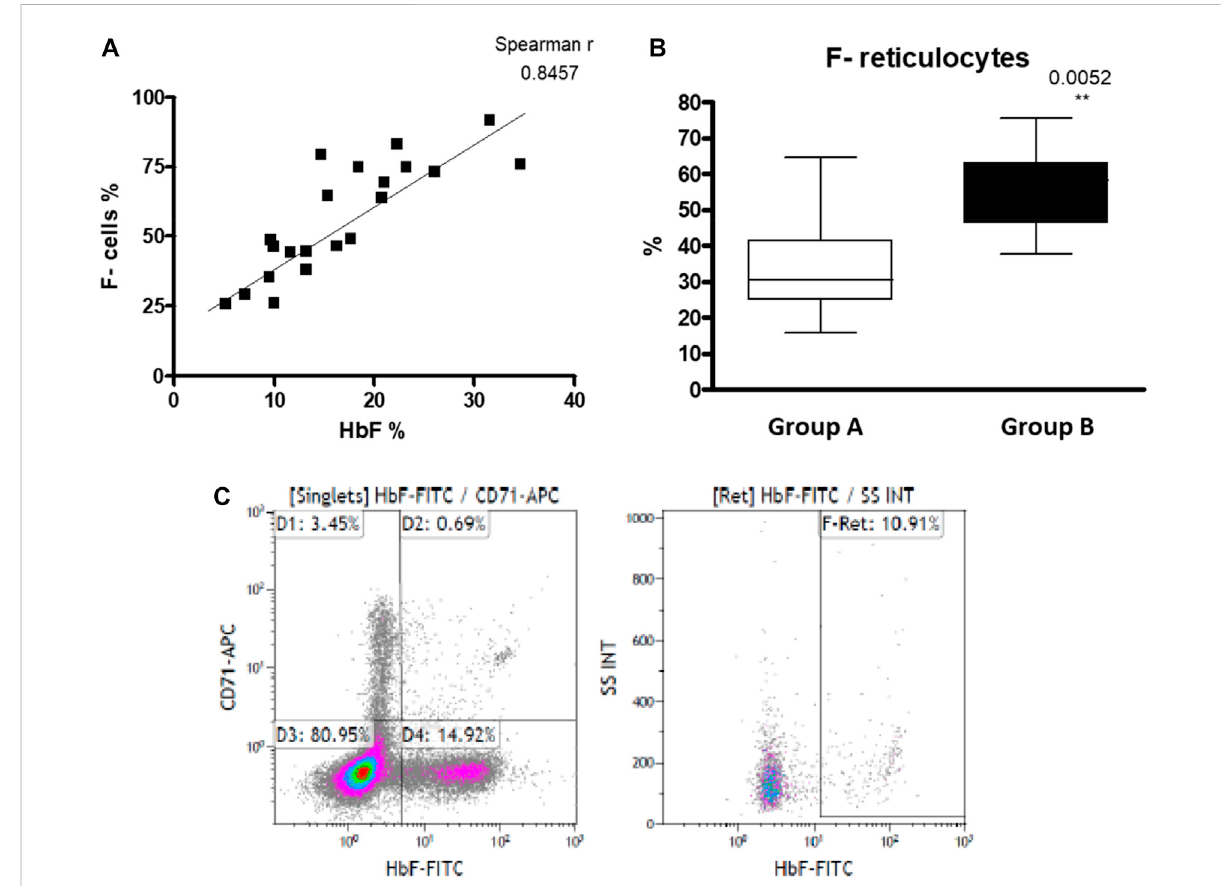
FIGURE 5 HbF in RBC of SCD patients: (A) HbF measured by HPLC and F- cells measured by FC positively correlates ( n = 21). (B) F- reticulocytes count in asplenic/hyposplenic ( n =14)vs.hypersplenic ( n =7)SCDsubjects. (C) representativeFCgating strategy forF-Reticulocytes. Group(A)patients with asplenia/hyposplenism, Group (B) patients with hypersplenism.